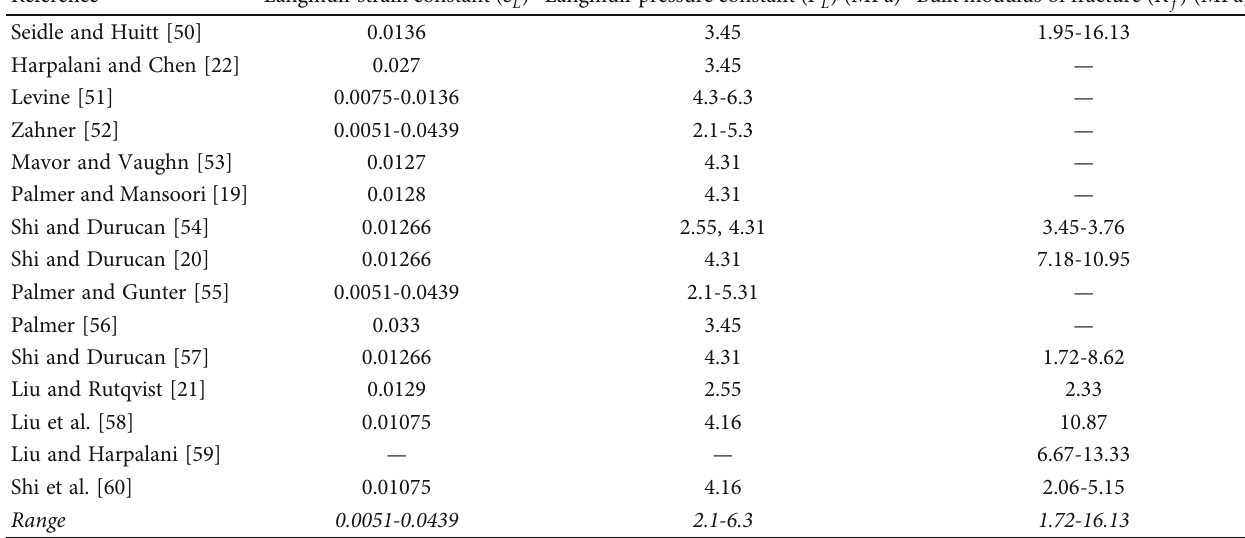
Table 4: Ranges of key